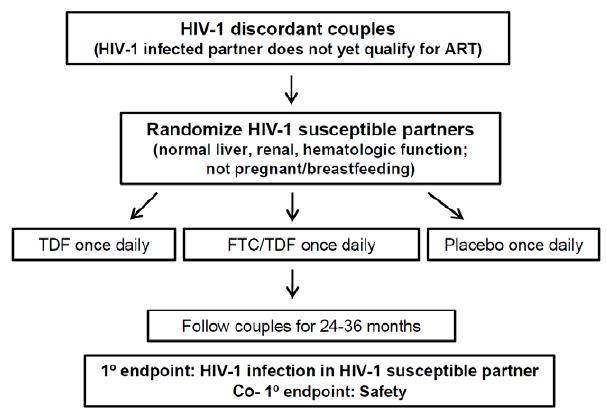
Figure 1. Study Schema.